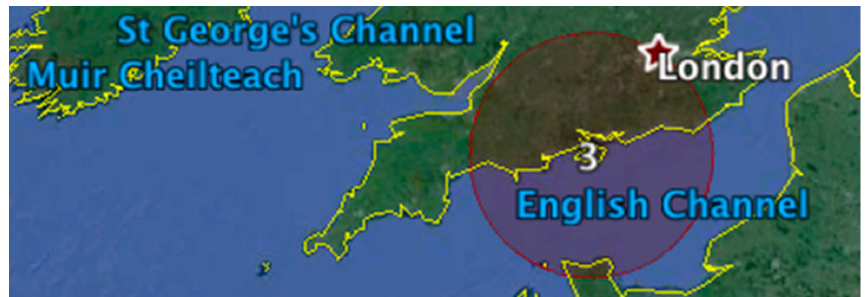
Figure 9. An event cluster encasing southern UK and the English Channel. This cluster contains 31 location IDs, an observed/expected ratio of 9.06, a relative risk of 9.24, and a p -value of 0.012.